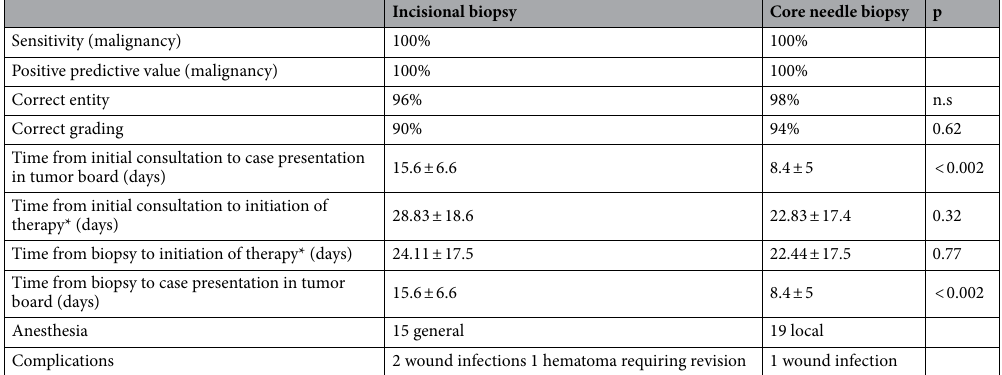
Table 3. Results of the pair-matched analysis on 19 pairs matched according to gender, age, and tumor characteristics: entity, localization, size, depth, and grading. Sixteen of 19 cases had a G3, > T3 sarcoma of the lower extremity. *Surgery, or beginning of neoadjuvant chemotherapy or radiation therapy.